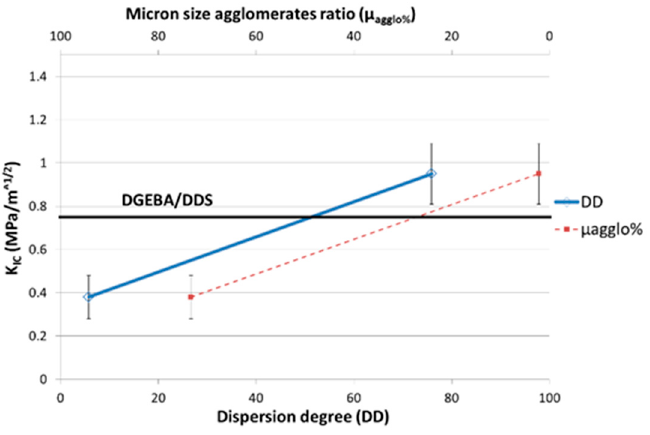
Figure 11. Fracture toughness (critical stress intensity factor K IC ) as a function of the MWNT dispersion degree in the DGEBA/DDS/MWNT nanocomposites (0.7 wt %).